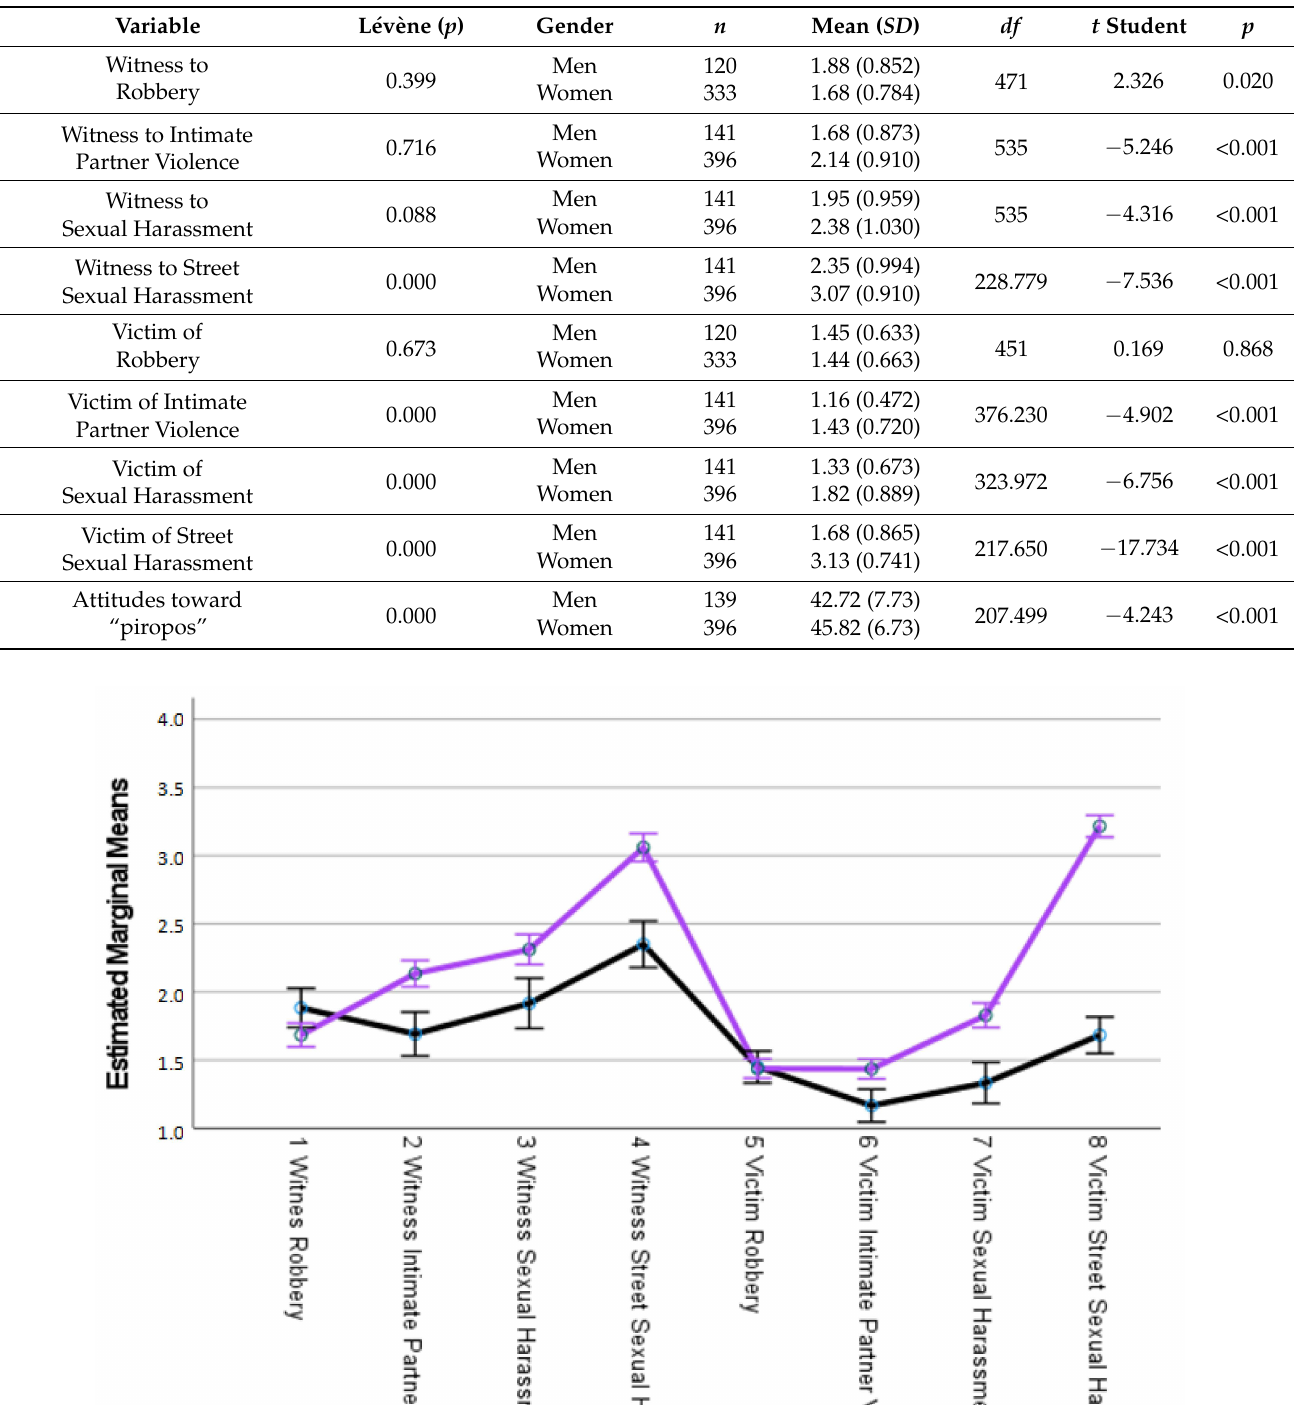
Table 5. Victimization and attitudes toward “piropos” by gender.